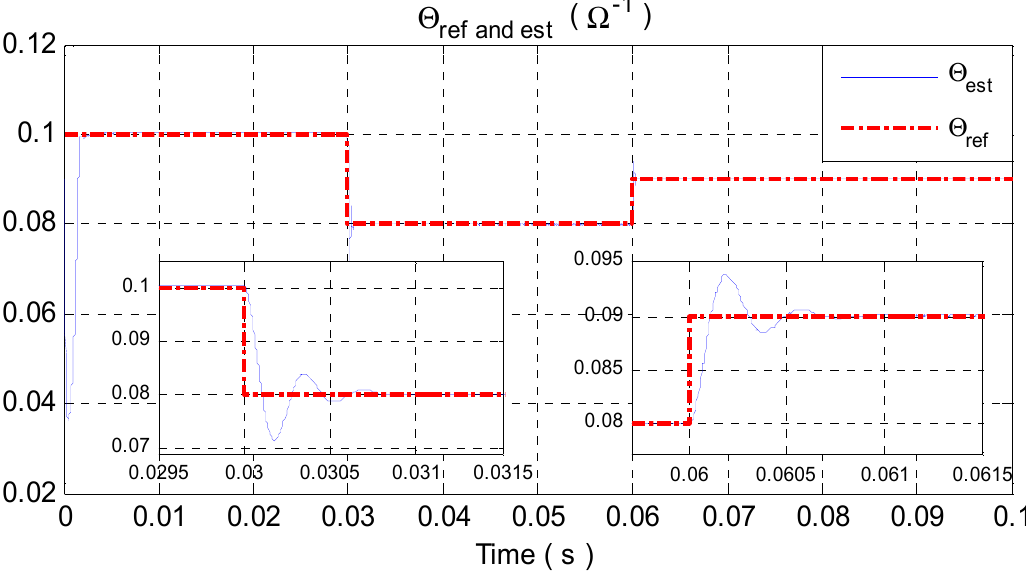
Figure 9. Estimate unknown parameter 𝜃 and its reference.